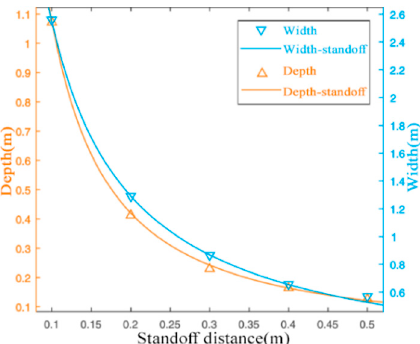
Figure 7. The correlation curve of scouring performance and standoff distance.